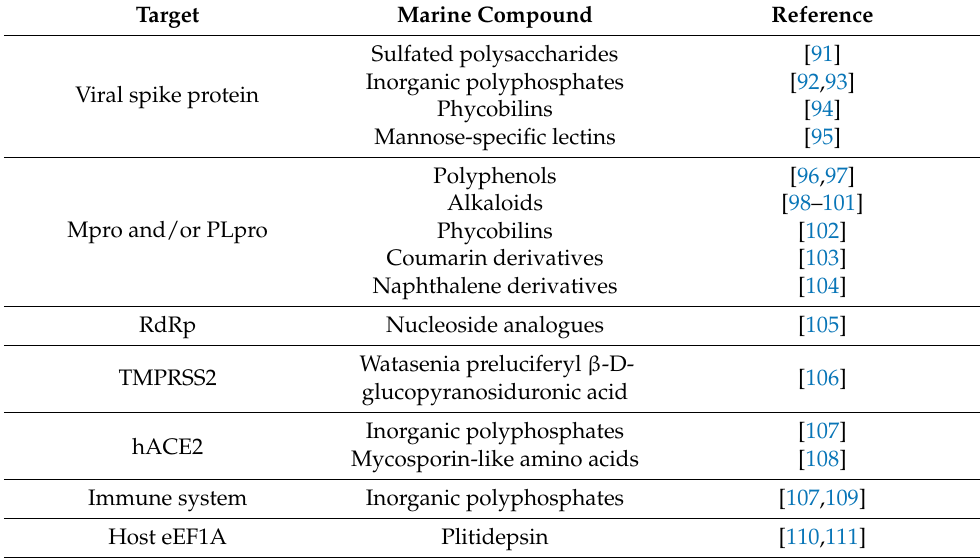
Table 2. Marine-derived compounds as potent inhibitors of SARS-CoV-2. Target Marine